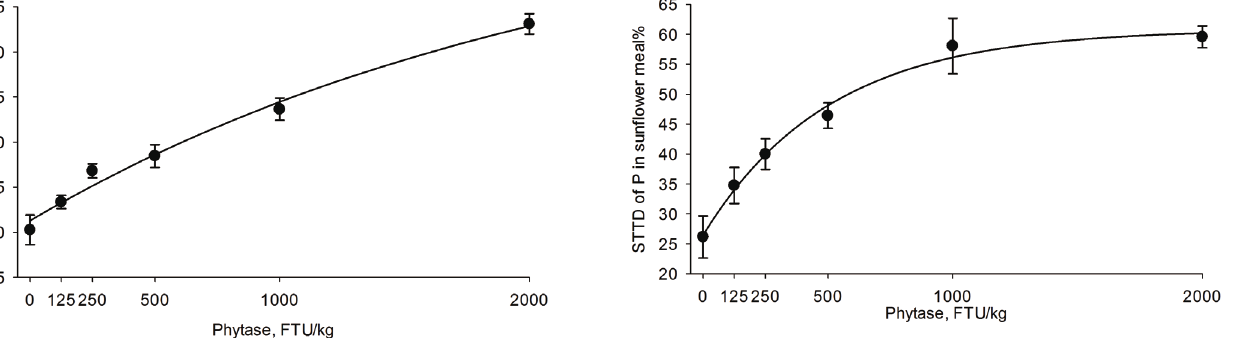
Figure 3. Fitted exponential model of standardized total tract digestibility (STTD) of P in rice bran as a function of concentration of exogenous phytase in the diet. Treatment means ( ● ) and standard error are shown. STTD of P = 11.5406+38.4744×[1–exp (–0.0004×phytase dose in FTU/kg)], r 2 = 0.99, p<0.001. The concentration of phytase needed to maximize (i.e., to obtain 95% of the upper asymptote) the STTD of P was estimated to be outside the studied range. FTU, phytase units.